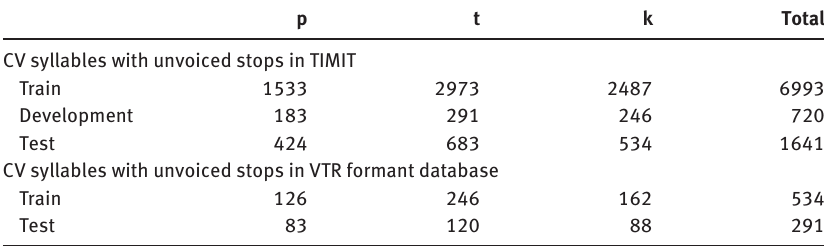
Table 1. Details of CV Syllables of Unvoiced Stops in the TIMIT and VTR Formant Databases.